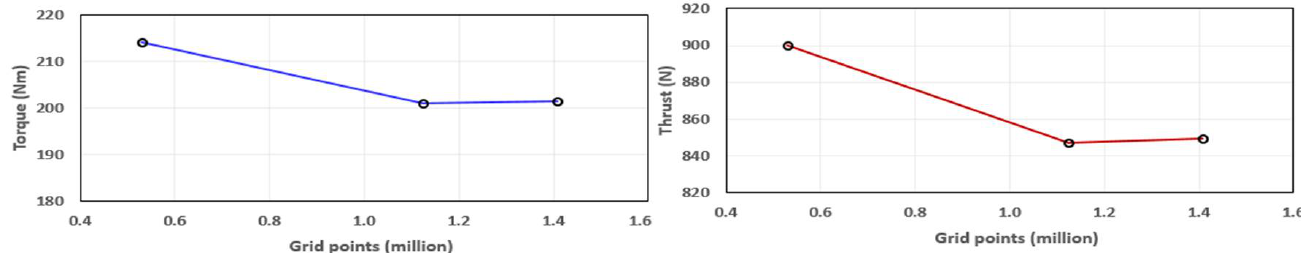
Figure 10. Grid convergence study for a propeller design in terms of thrust and torque with varying grid points.